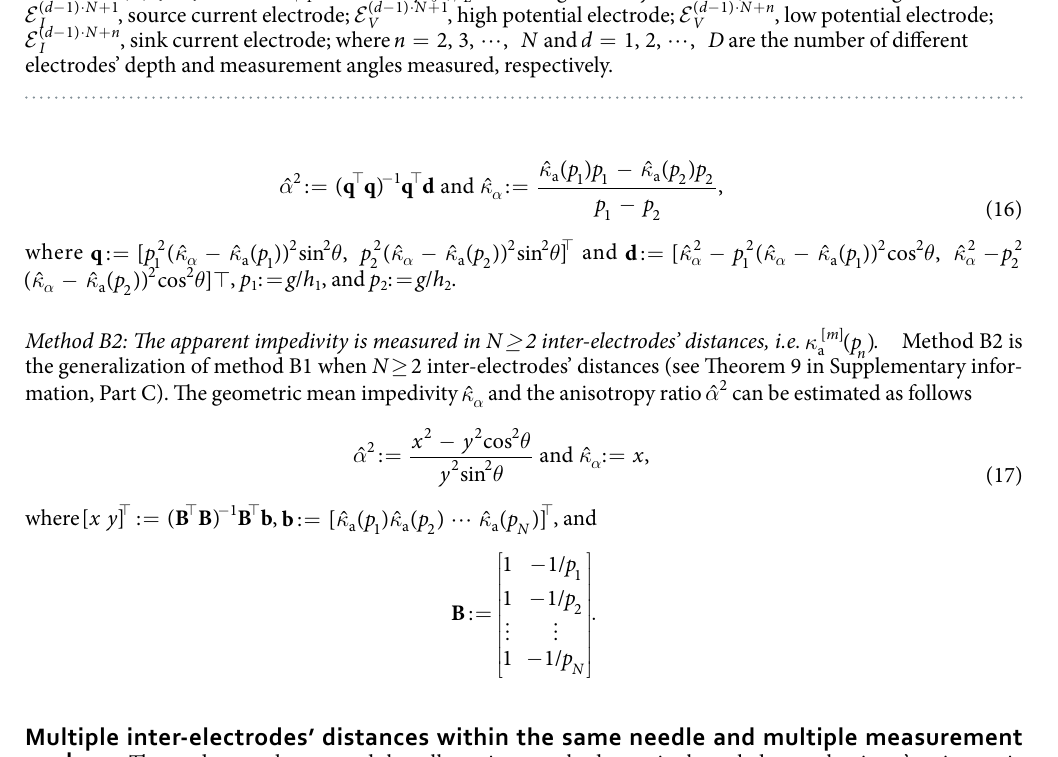
Figure 14. ( A ) Schematic showing the in situ measurement of anisotropic permittivity in N ≥ 2 inter- electrodes’ distances and D ≥ 3 measurement angles using multipolar needles. ( B ) Schematic of the n -th depth and d -th angle measured. The measurement angle θ d is defined with respect to the unknown muscle fibers’ transverse (T) { x , z } direction φ T modeled by ξ ( φ L is the longitudinal y direction). Electrode